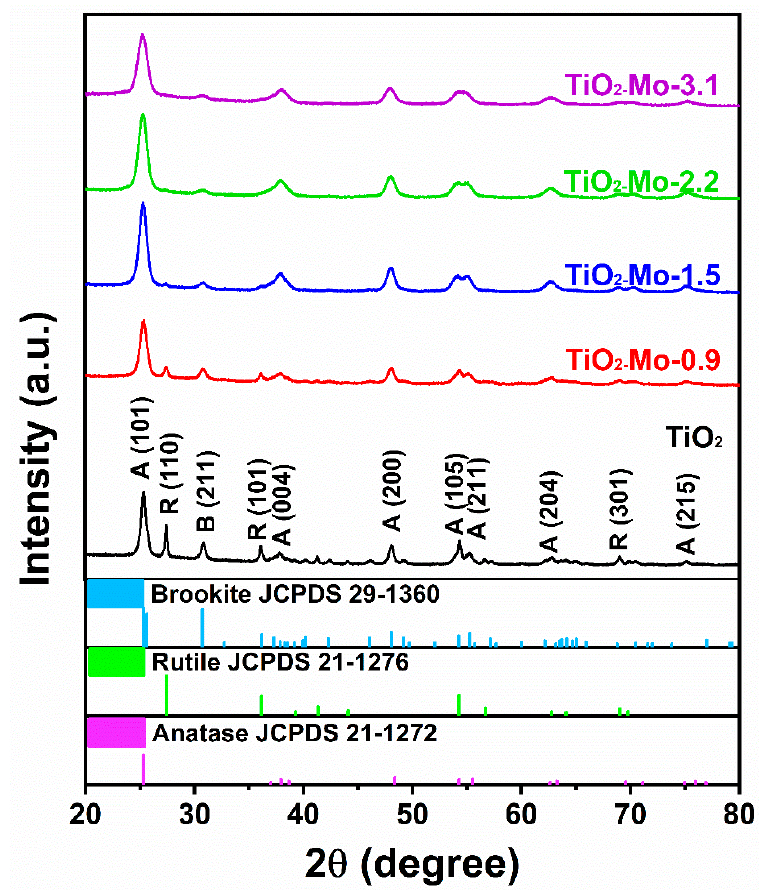
Figure 4. XRD spectra of studied nanomaterials. Table 2. Summary of some previous studies demonstrating the synthesis of Mo-doped TiO 2 .